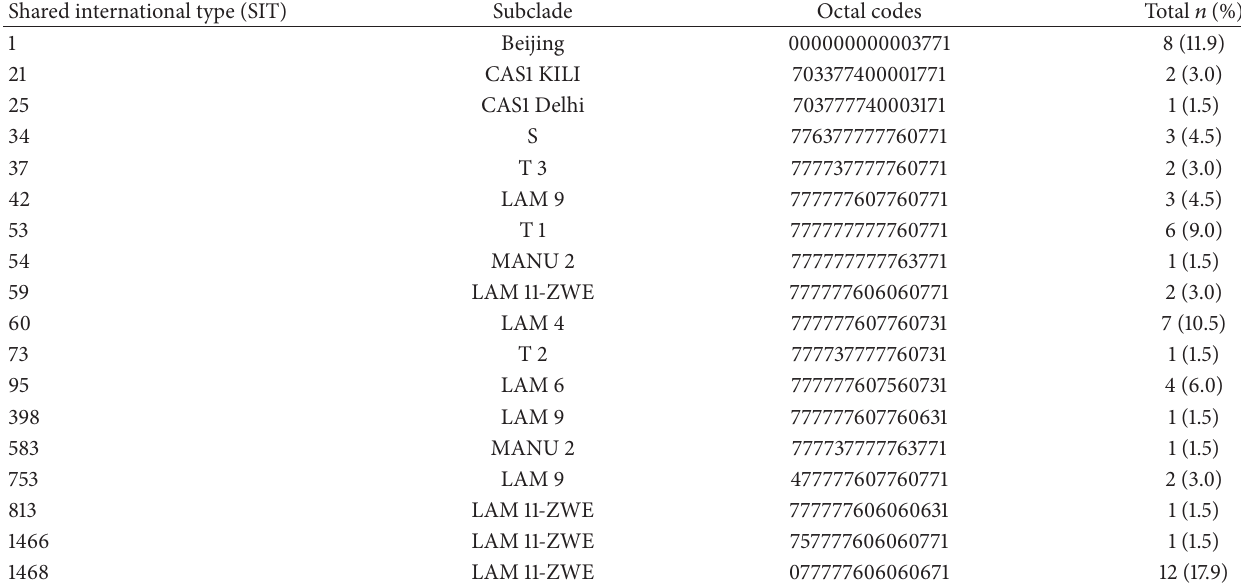
Table 2: Spoligotyping signatures of MDR-TB isolates.